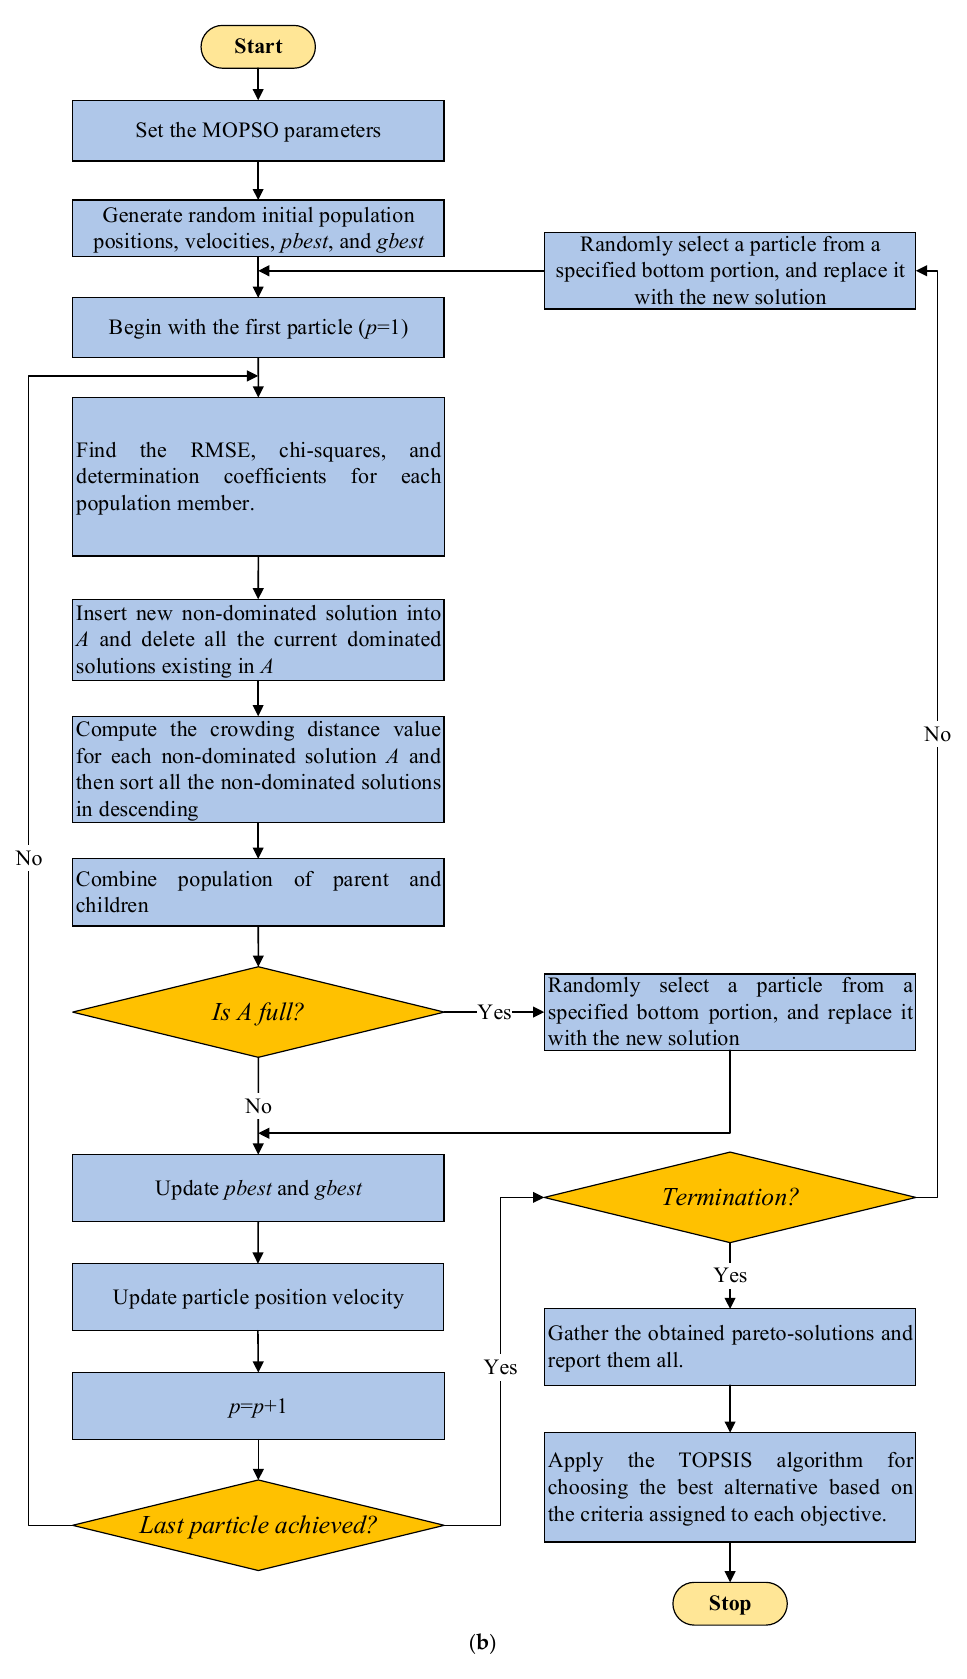
Figure 2. Flowchart of the used multiobjective optimization algorithms: ( a ) NSGA-II, ( b )